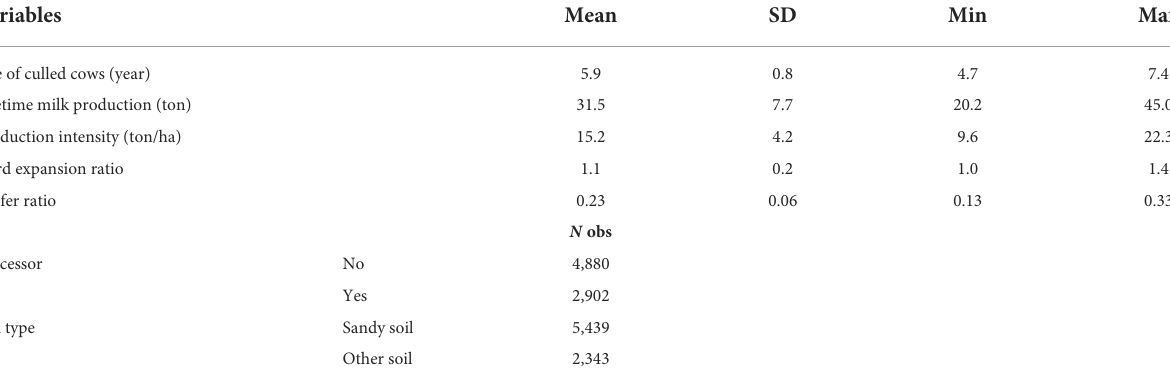
TABLE 1 Descriptive statistics of the selected covariates in the bootstrap truncated regression based on the herd data from 2007 to 2014 ( n = 7,782).